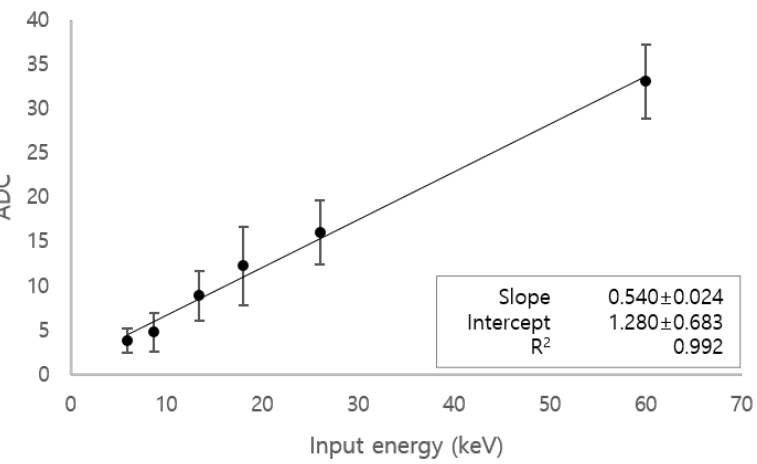
Figure 7. Linearity between energy and ADC counts. Conversion factor is 1.837 keV per ADC count.